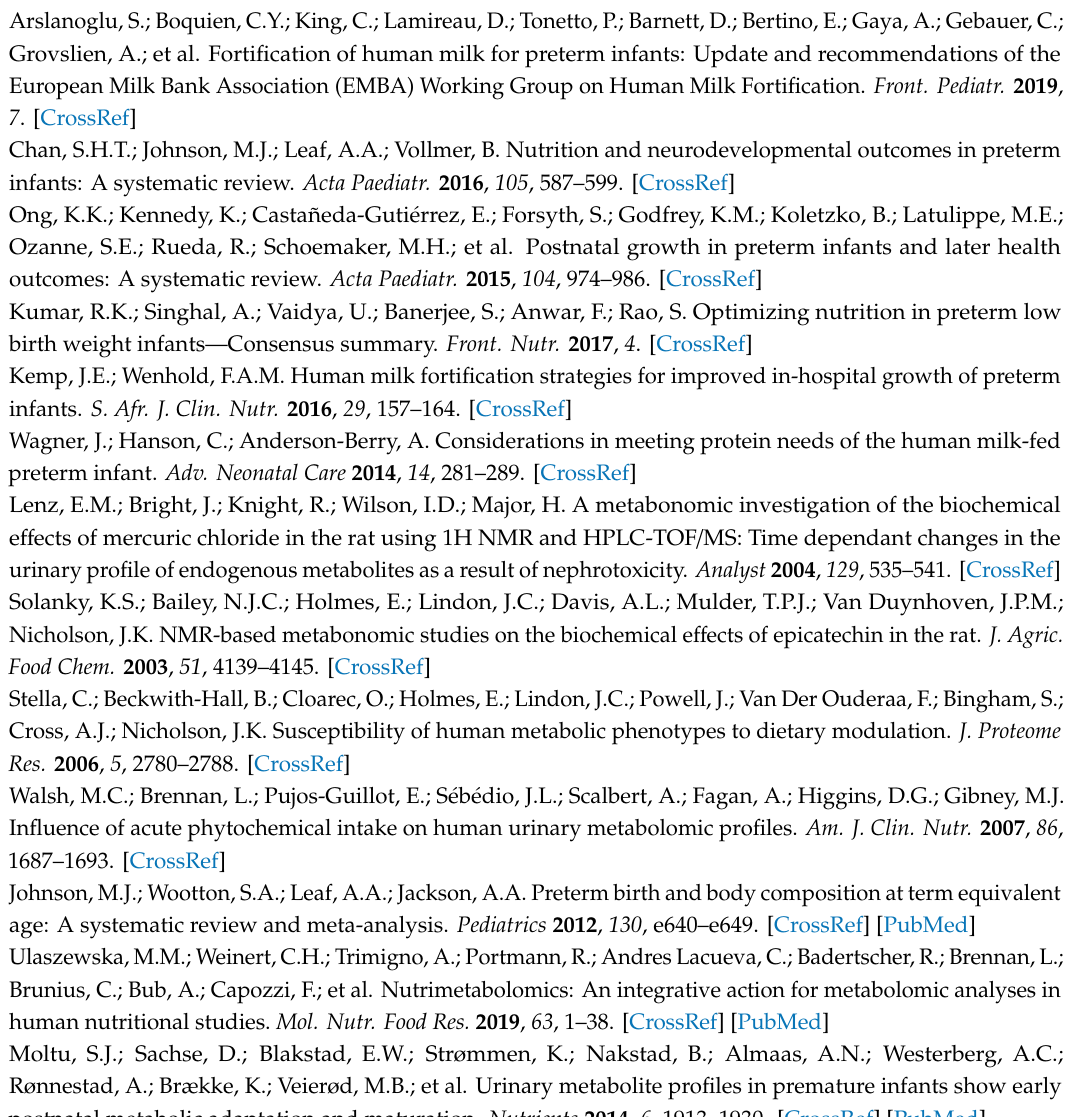
Table S1: Composition of protein fortifiers used in the trial, Figure S1: Representative 1 H NMR spectra of preterm infant urine before and after ADJ fortification, Figure S2: PC1 vs. PC2 scores plot of the PCA model built from 1 H NMR spectra of urine samples collected from preterm infants before ADJ